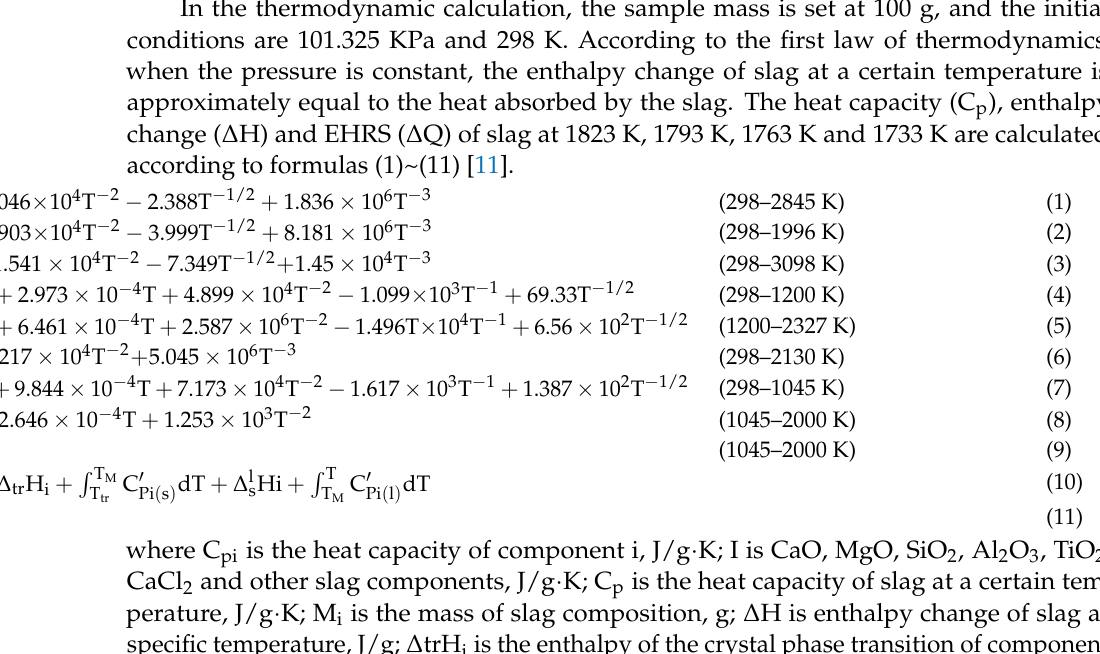
Figure 2. The calculation process of the extreme heat release of slag.